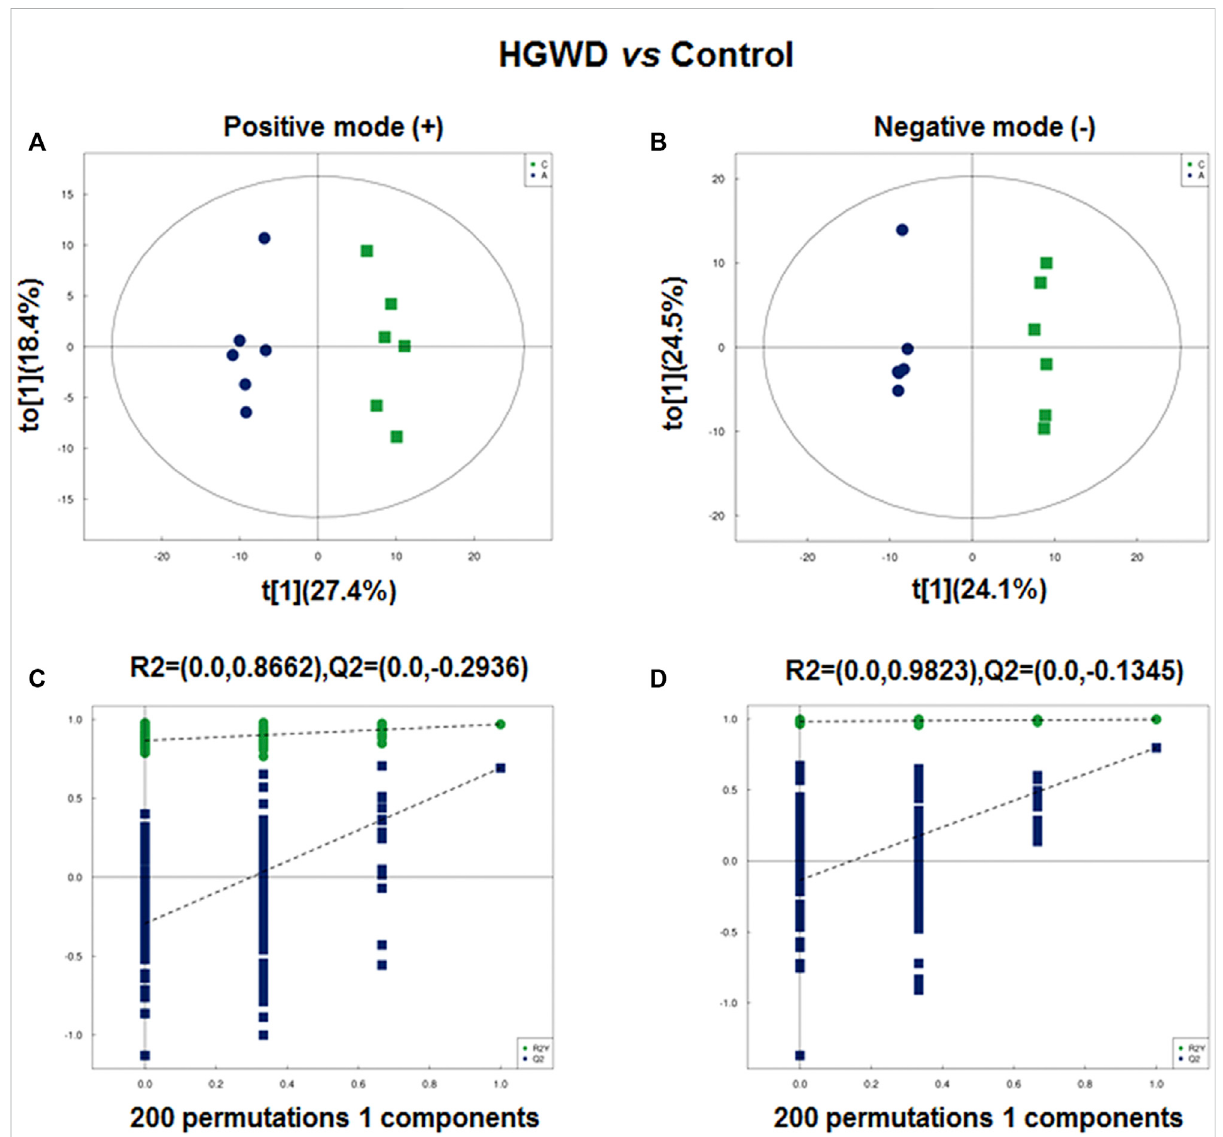
FIGURE 6 Plasma metabolomic analysis of xenografted CC tumors of C57BL/6 mice treated with HGWD. (A,B) Orthotopic partial least-squares discriminant analysis (OPLS-DA) score plots. A, positive ion; B, negative ion (C,D) Permutation tests for OPLS-DA score plots. C, positive ion; D, negative